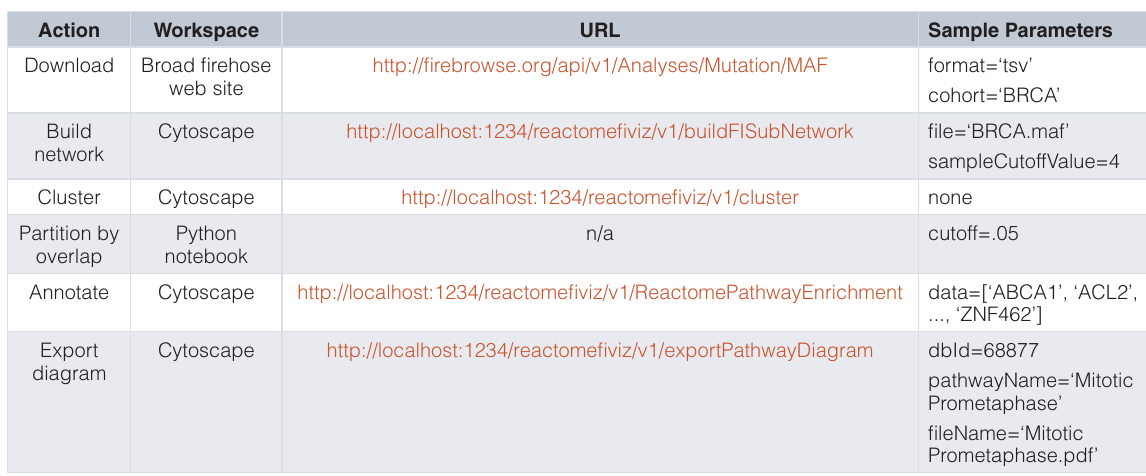
Table 2. List of actions performed in the use case